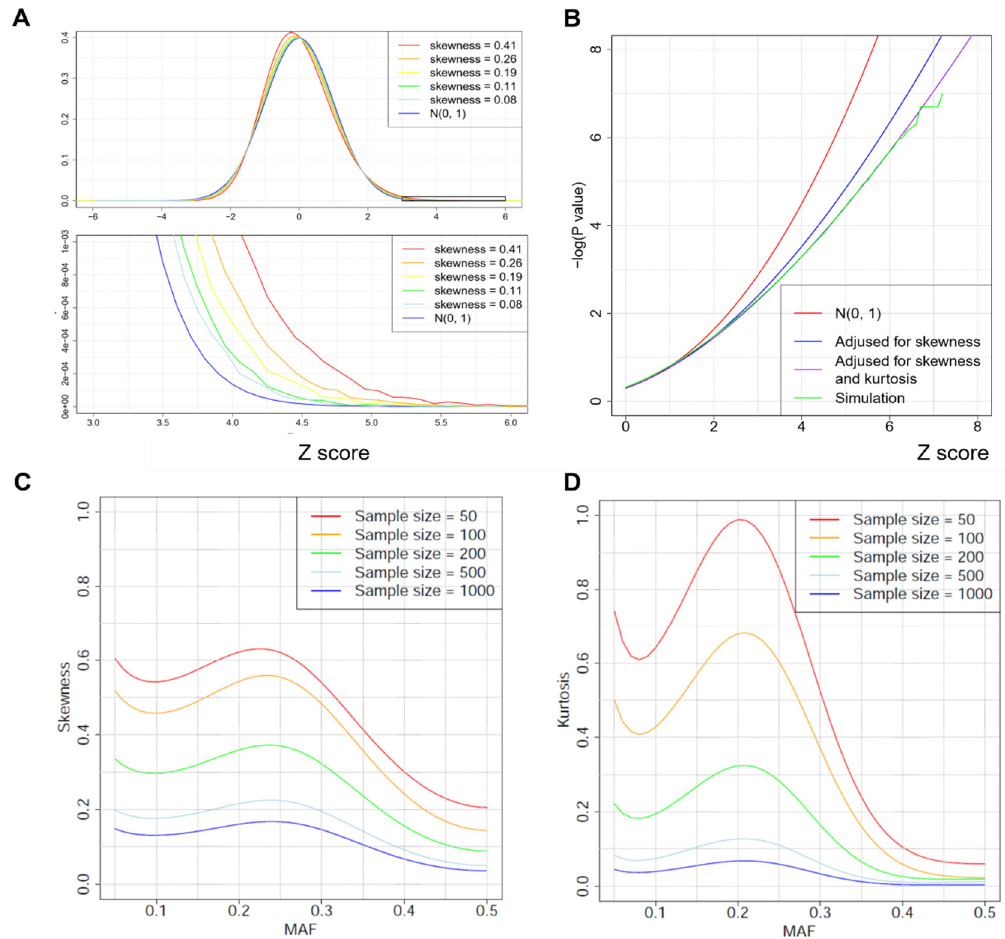
Figure 3. Correcting tail probabilities for skewness and kurtosis. ( A ) The standard normal distribution N ( 0,1 ) and an approximately normal distribution with positive skewness. The skewness has big impact when calculating the tail probability P ( Z > b ) for a large value of b . ( B ) Numerical evaluation of tail probability approximation for Z M . We used the unweighted UniFrac distance matrix of 500 samples from the American Gut Project (AGP). For each value of b ( > 0 ) , we calculated p -values P ( Z M > b ) based on N ( 0,1 ) , skewness correction, both skewness and kurtosis correction, and 10 8 simulations. ( C ) Skewness depends on minor allele frequency (MAF) of SNPs and the sample size of the study, calculated based on the weighted UniFrac distance matrix in AGP data. ( D ) Kurtosis depends on MAF of SNPs and the sample size, calculated based on the weighted UniFrac distance matrix in the AGP data.